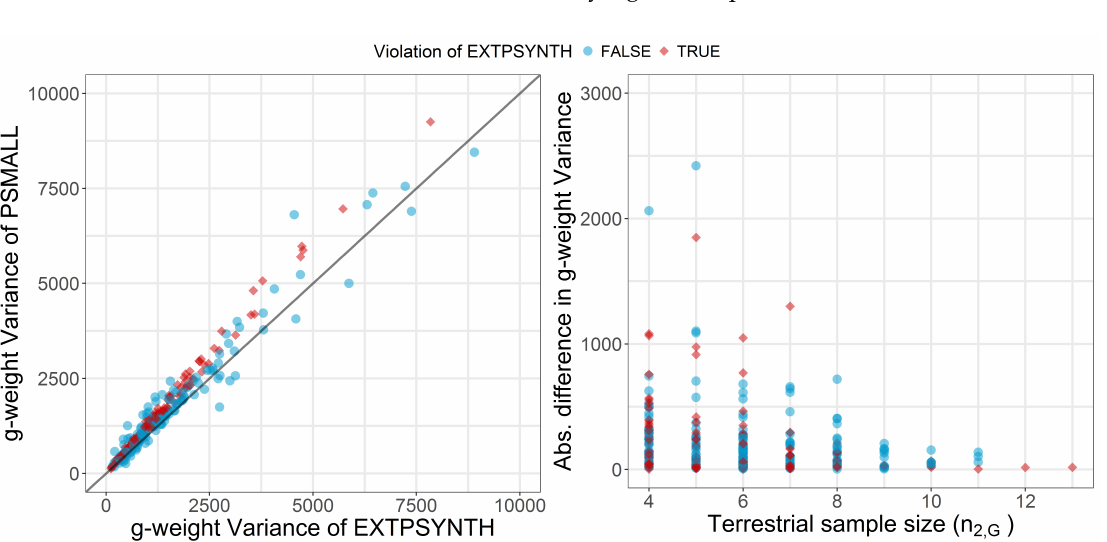
Figure 4. ( Left ): Comparison of the g-weight variance between the PSMALL and the EXTPSYNTH estimator for the 321 FR units. ( Right ): Difference in g-weight variance between the PSMALL and the EXTPSYNTH estimator in dependence of the terrestrial data ( n 2, G ) in the FR